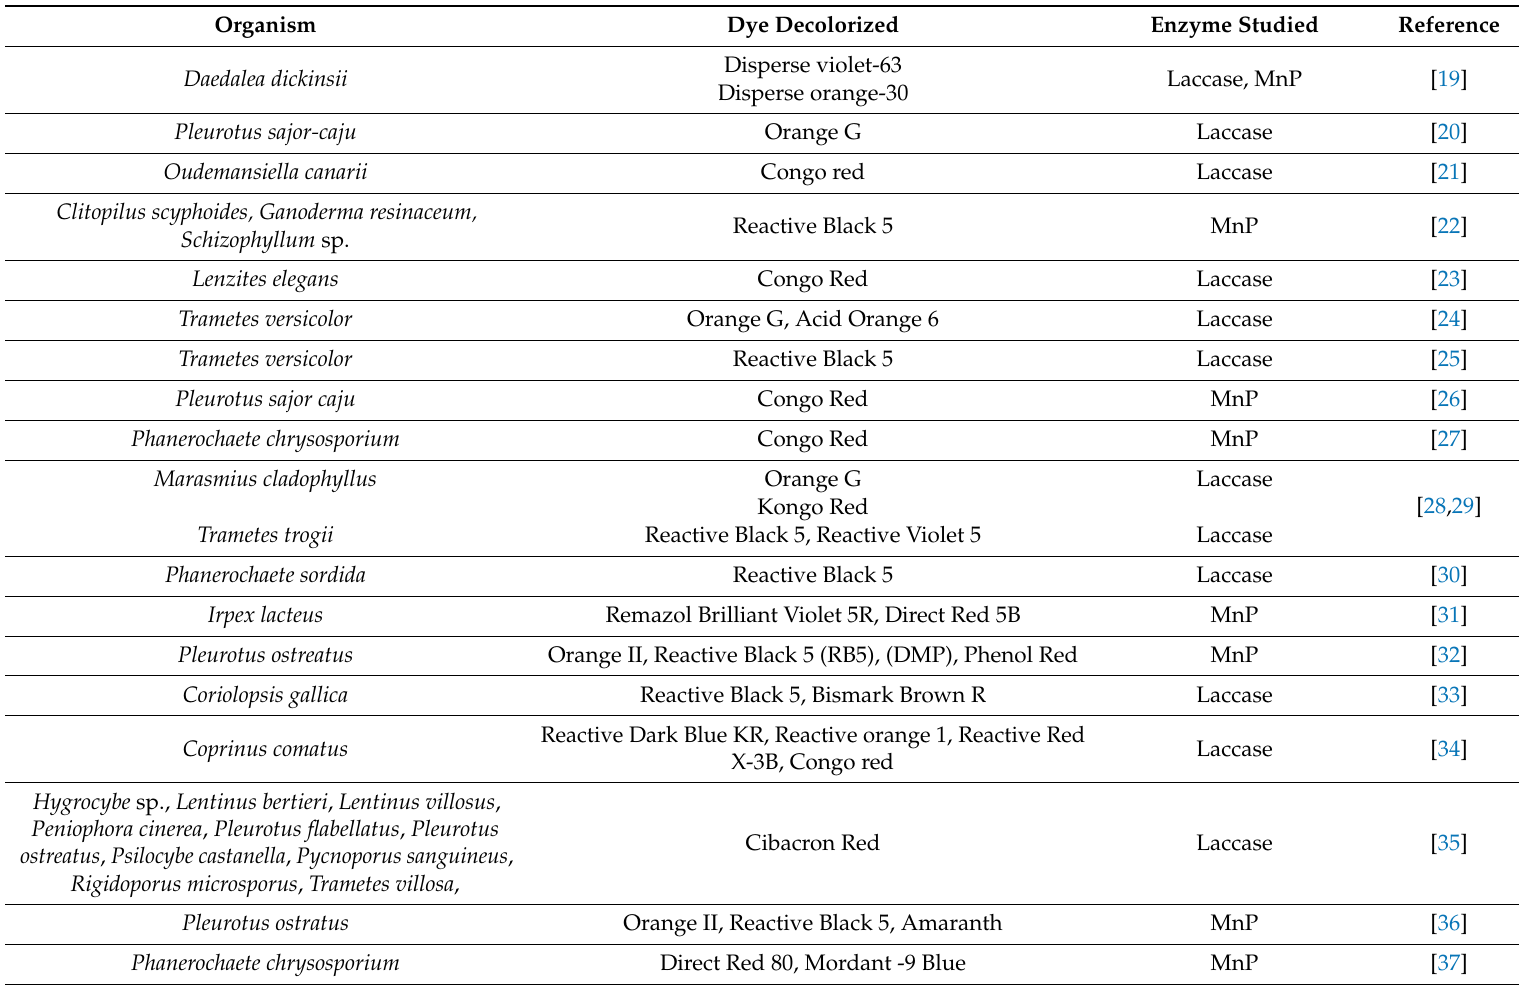
Table 1. Overview of the azo-dye decolorization capacity and laccase and Mn-peroxidase (MnP) production in